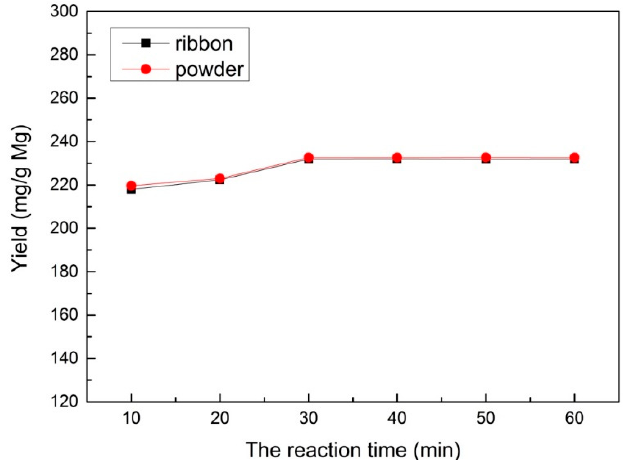
Figure 4. The yield under different reaction times prepared with an Mg ribbon and Mg powder.